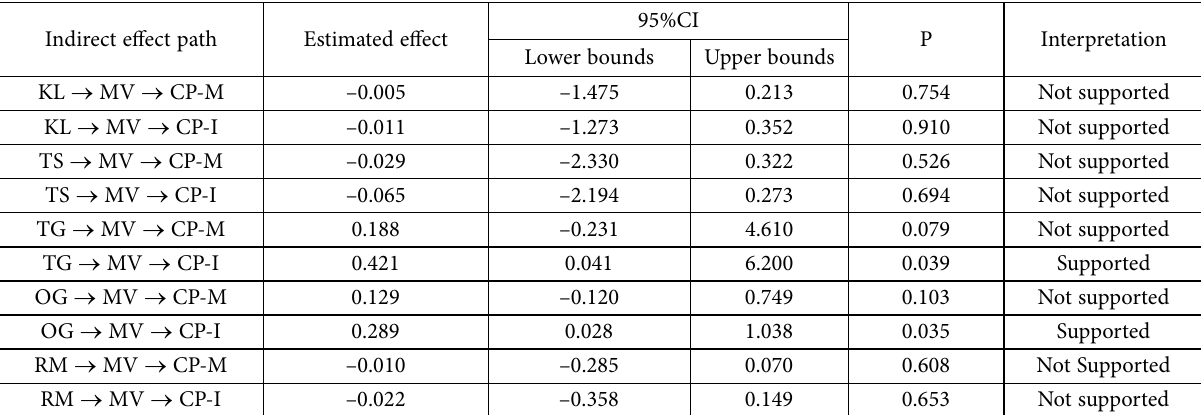
Table 6. Indirect effects and 95% confidence intervals for the final